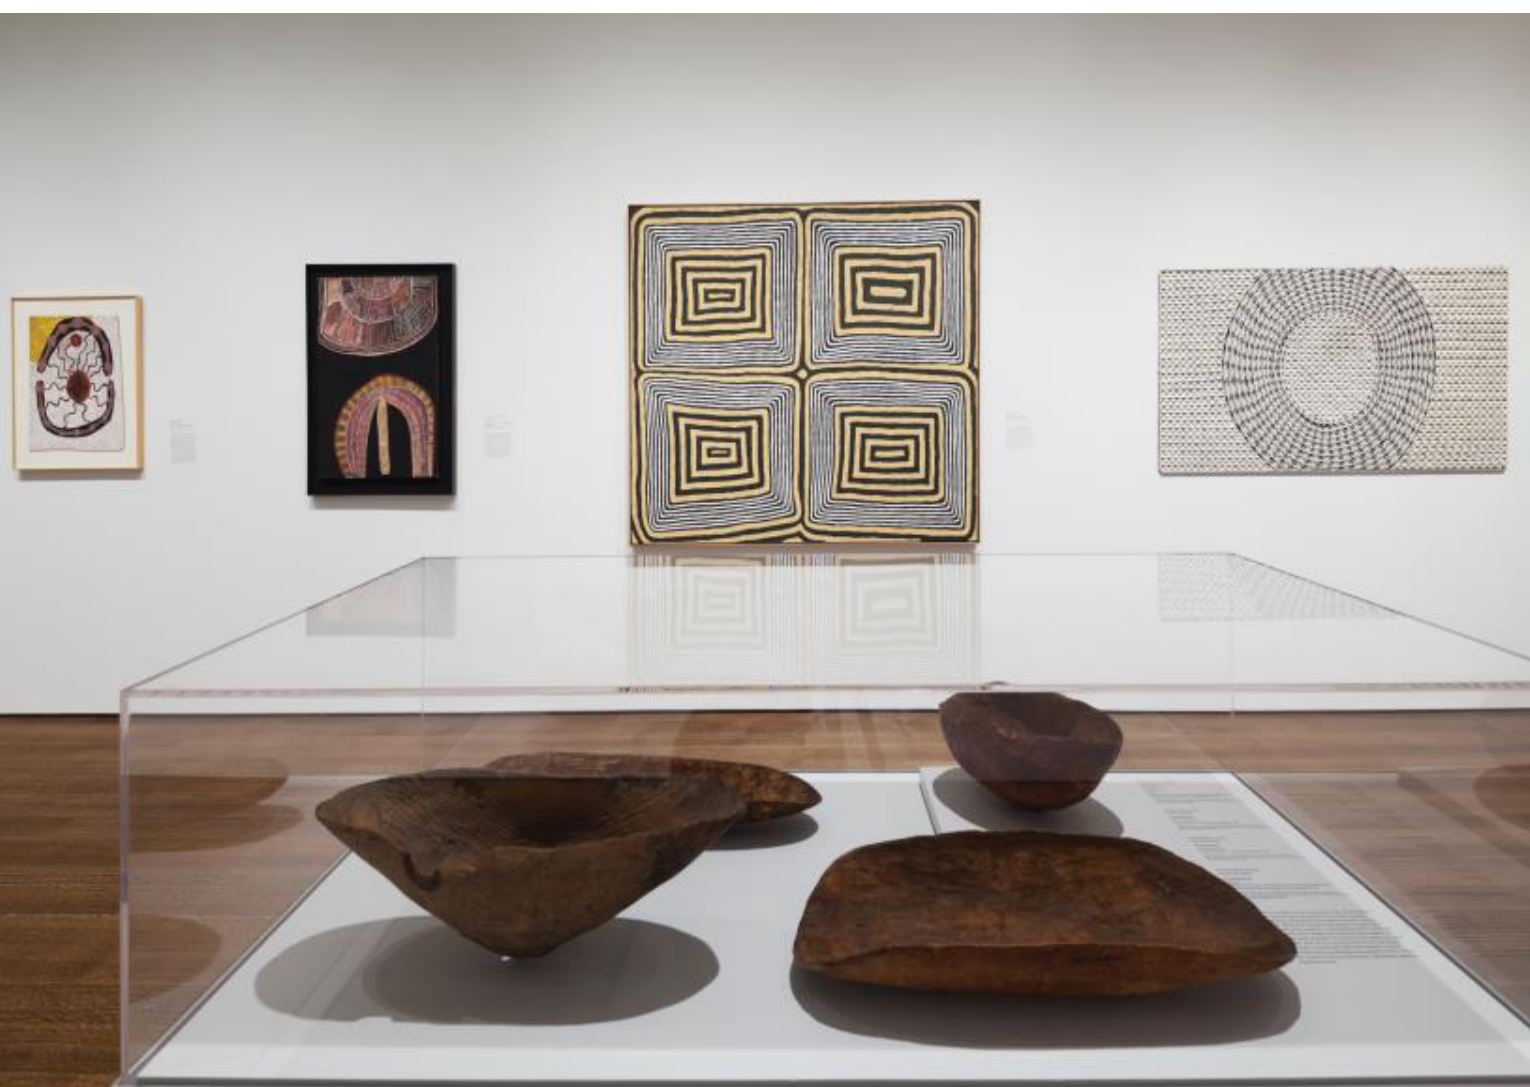
Figure 2 Installation view of “Transformation” module from Everywhen: The Eternal Present in Indigenous Art from Australia, Harvard Art Museums, Cambridge, MA, curated by Stephen Gilchrist. Works background, left to right: Walter Tjamlitjinpa, Rainbow and Water Story , 1972; Mick Namararri Tjapaltjarri, Big Cave Dreaming with Ceremonial Object , 1972; Ronnie Tjampitjinpa, Two Women Dreaming , 1990; and Gunybi Ganambarr, Buyku , 2011. Foreground, left to right: Unidentified artist, Coolamon , c.1896- 1931; Unidentified artist, Coolamon , c.1896-1931; Unidentified artist, Coolamon , c.1951; and Unidentified artist, Coolamon , c.1951. Image Courtesy Harvard Art Museums, © President and Fellows of Harvard